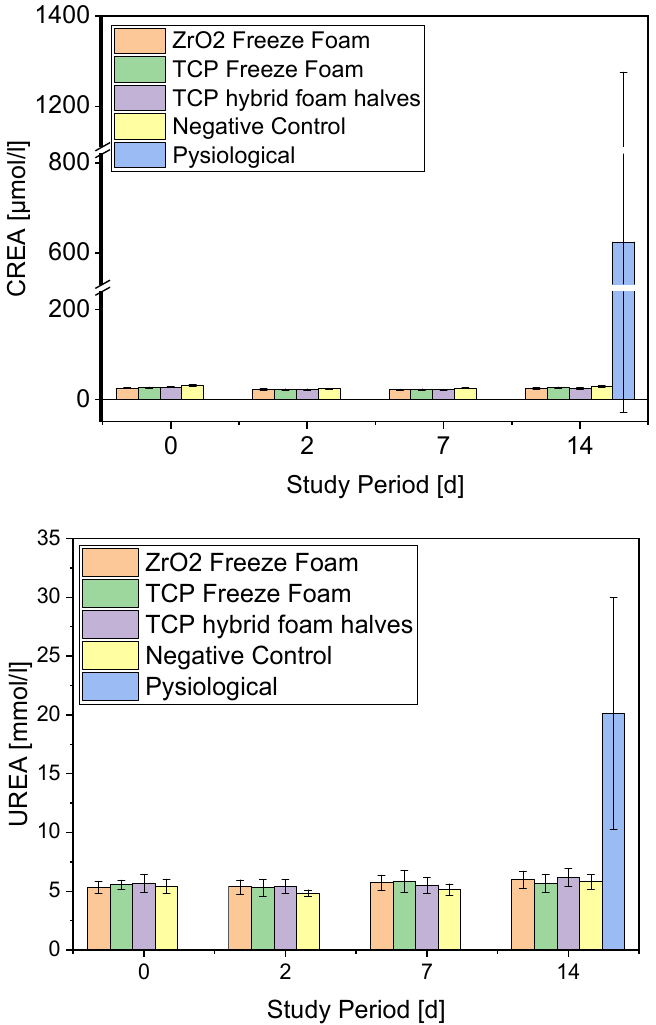
Figure 18. Concentrations of creatinine and urea from days 0 to 14. For clarity, the physiological control values were only entered for CREA and UREA at day 14. The physiological values for creatinine (CREA) and UREA were taken from Boehm et al. [35].